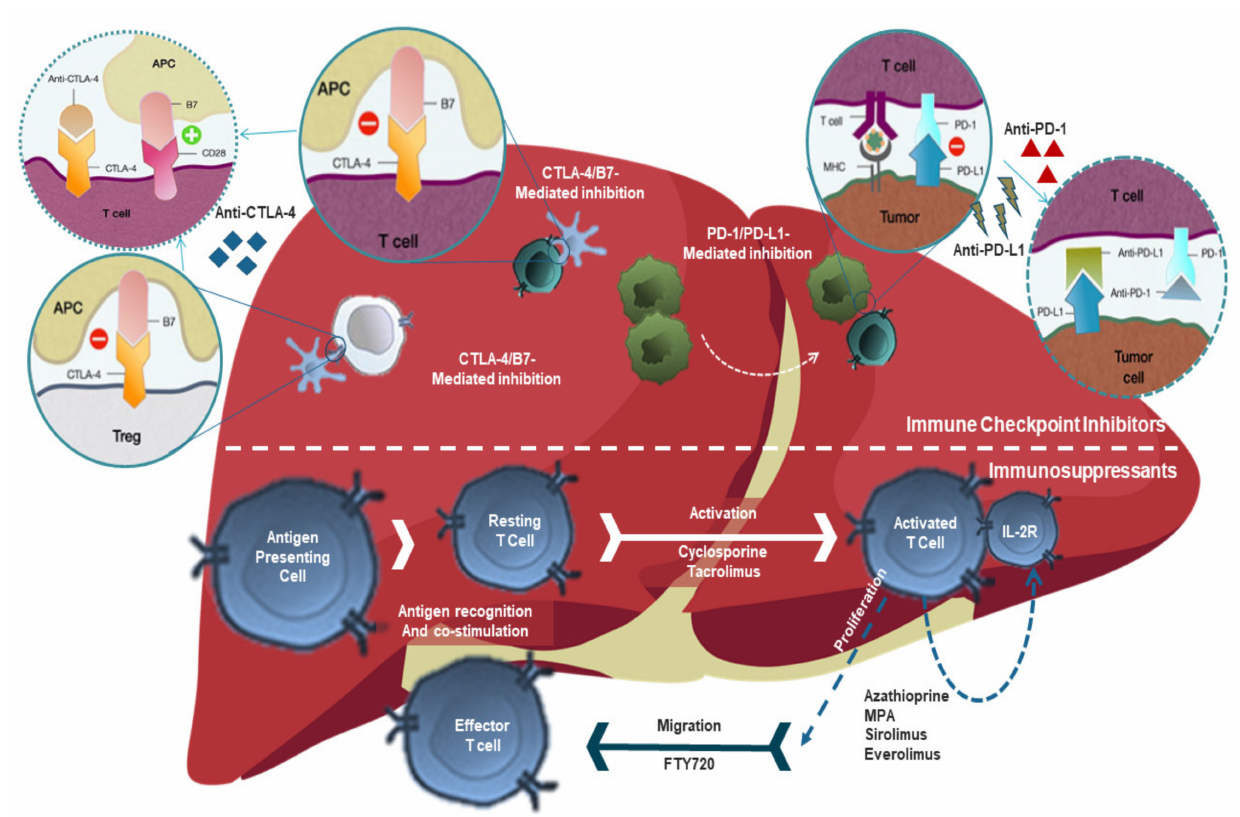
Figure 1. The mechanism of action of immunosuppressants versus immune checkpoint inhibitors. The mechanism of action of checkpoint inhibitors is to prevent the “off” signal from being sent, allowing the T cells to kill cancer cells. Such drugs that act against the checkpoint proteins are called CTLA-4 inhibitors, PD-1 inhibitors, and PD-L1 inhibitors. While the mechanism of action of immunosuppressants is that they all function to prevent allograft rejection by preventing/inhibiting cell activation, cytokine production, differentiation, and/or proliferation. ICPI: Immune Checkpoint Inhibitors, PD-1: Programmed Death-1, IST: immunosuppressive therapy, APA , Antigen-presenting cell; CTLA-4 , cytotoxic T-lymphocyte–associated antigen 4; PD-L1 , Programmed death-ligand